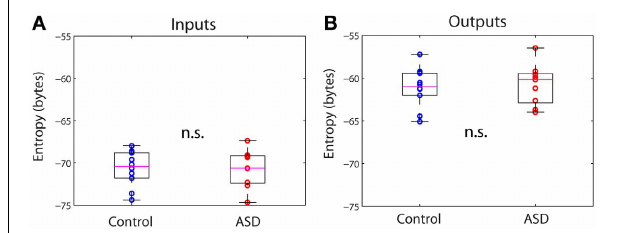
FIGURE 3 | Differential entropies of the inputs and outputs. (A) Inputs. (B) Outputs. There are no significant differences between groups in either case.